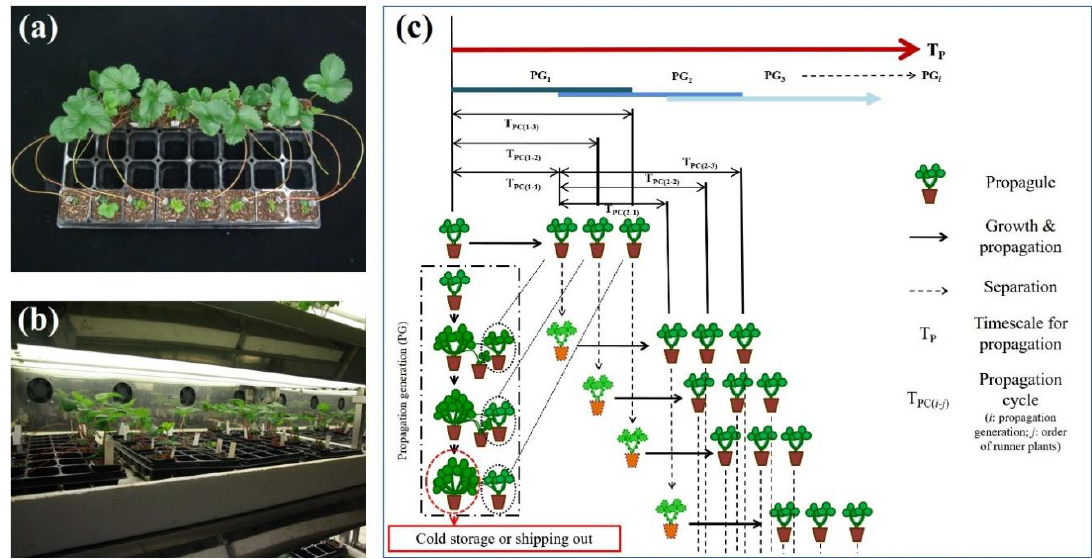
Figure 1. Arrangement of propagules on a 32-cell plug tray ( a ) and a cultivation bed (1.2 m × 0.6 m; ( b ) in a T-PFAL, and schematic diagram of runner plant production in ATPM ( c ) .